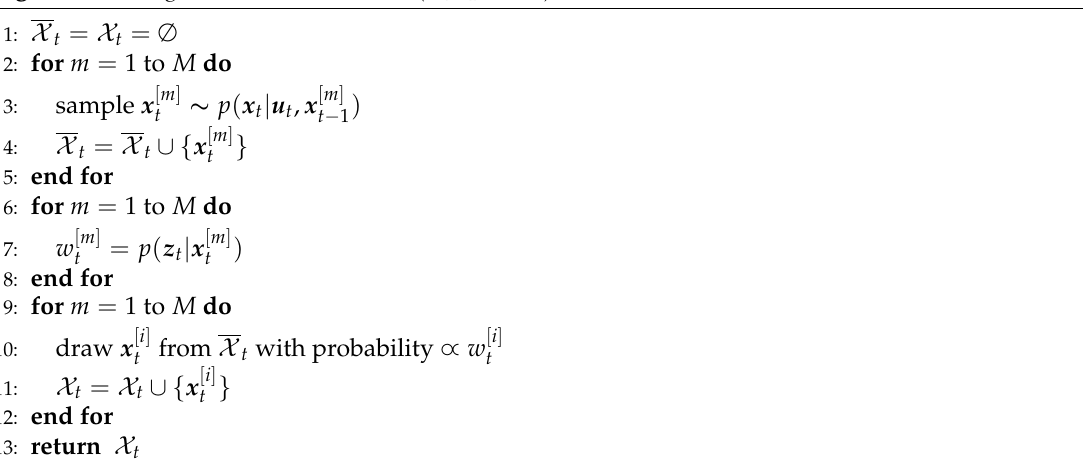
Algorithm 1 Augmented Particle Filter ( X t − 1 , u t , z t )